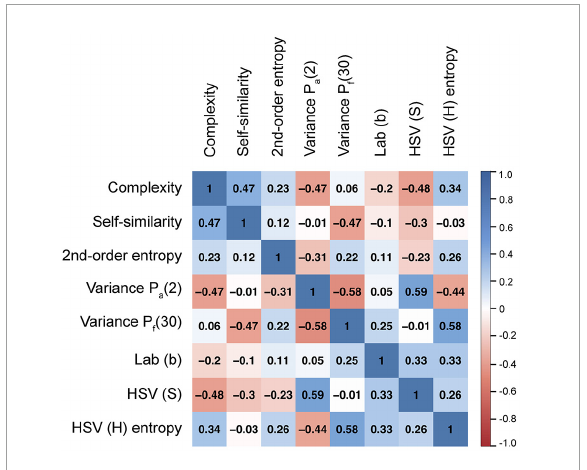
FIGURE3 Correlation matrix for the eight SIPs that were investigated. The numbers represent the Spearman’s coefficients ρ that were calculated for the 150 style-transferred images. The color indicates positive ( blue ) and negative ( red ) correlations. The shading represents the strength of the correlations, with darker shadings representing stronger correlations (see color